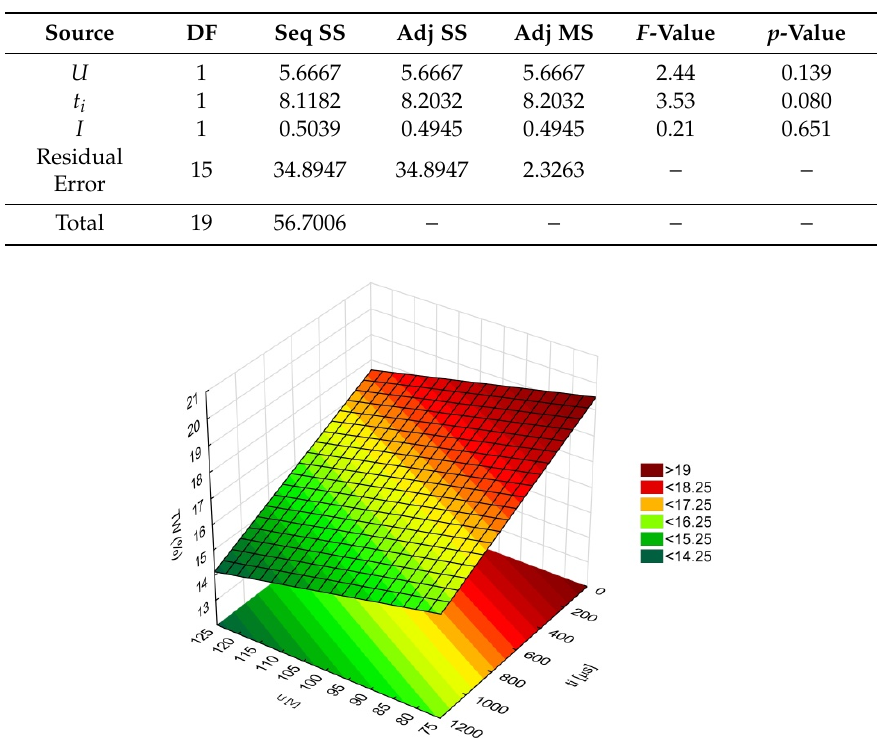
Figure 11. Relationship between linear tool wear ( TW ), and discharge voltage ( U ), and pulse time ( t i ); I = 3.83 A.